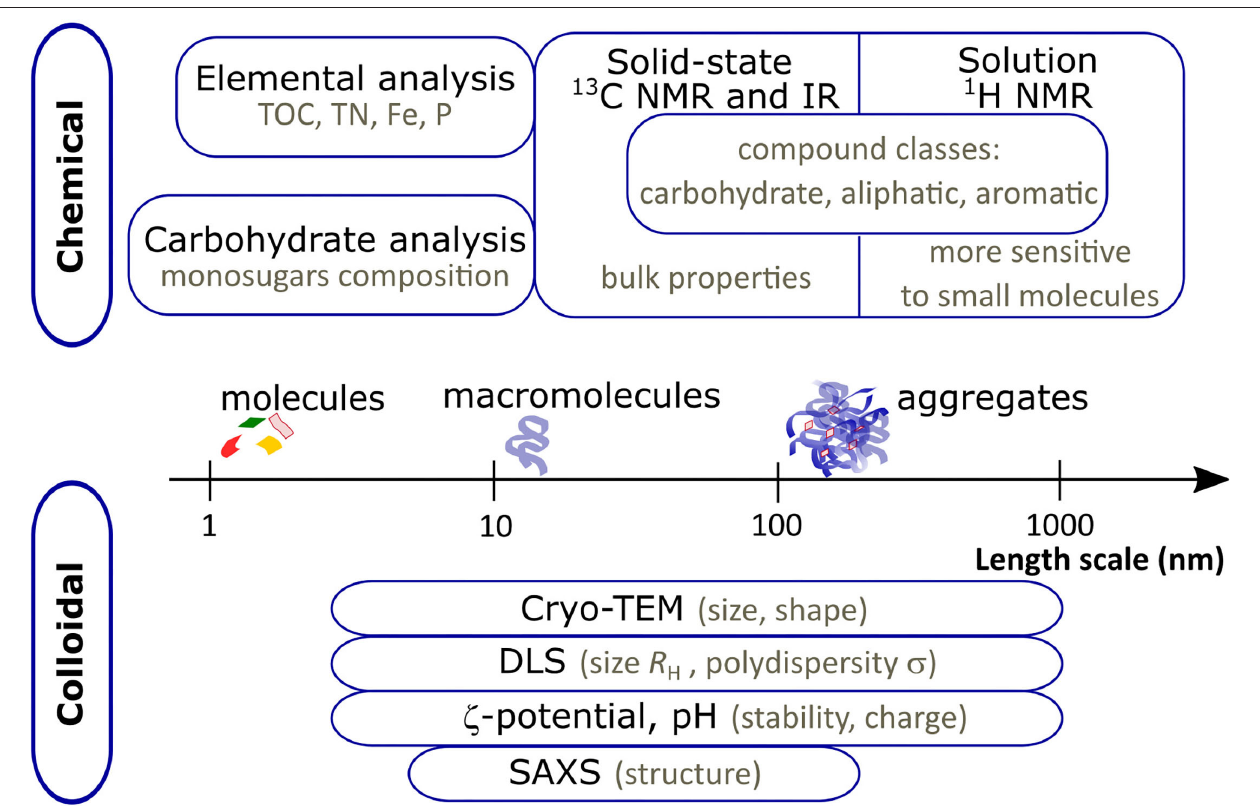
FIGURE 1 | Schematic diagram summarizing the chemical and colloidal characterization methods used in the study with main outcomes of the experiments. The length scale corresponds to the size probed with colloidal